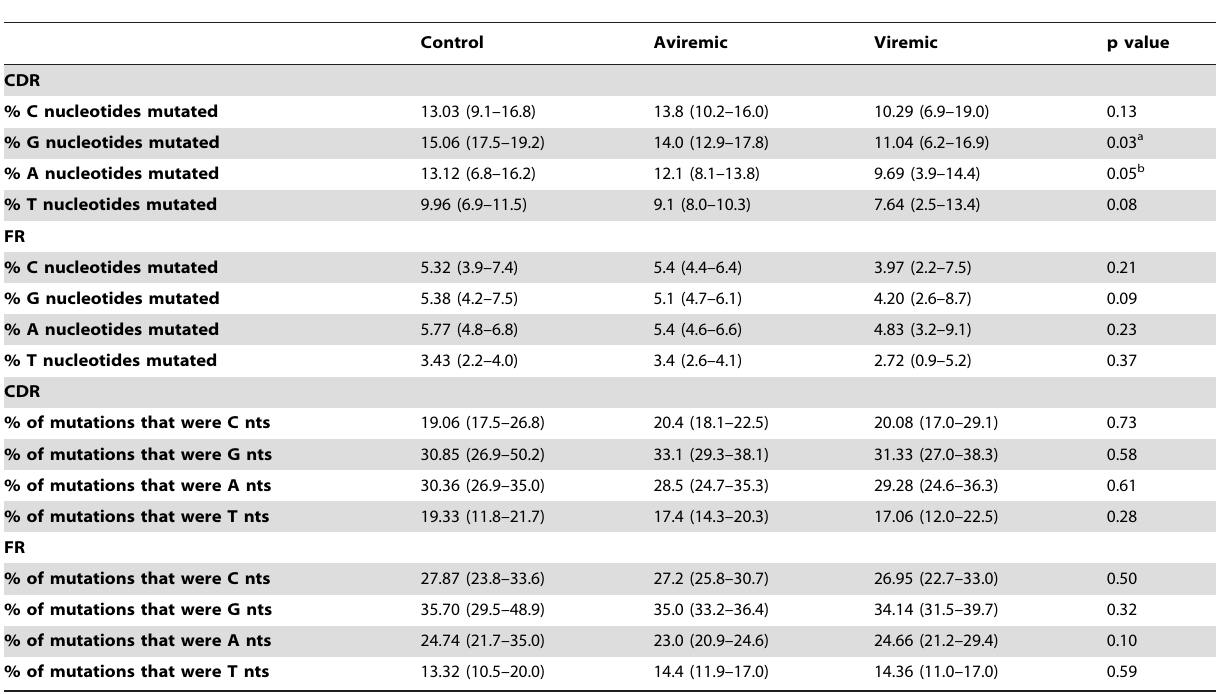
Table 4. Nucleotide mutation patterns and proportions in IgG V H 3 mRNA